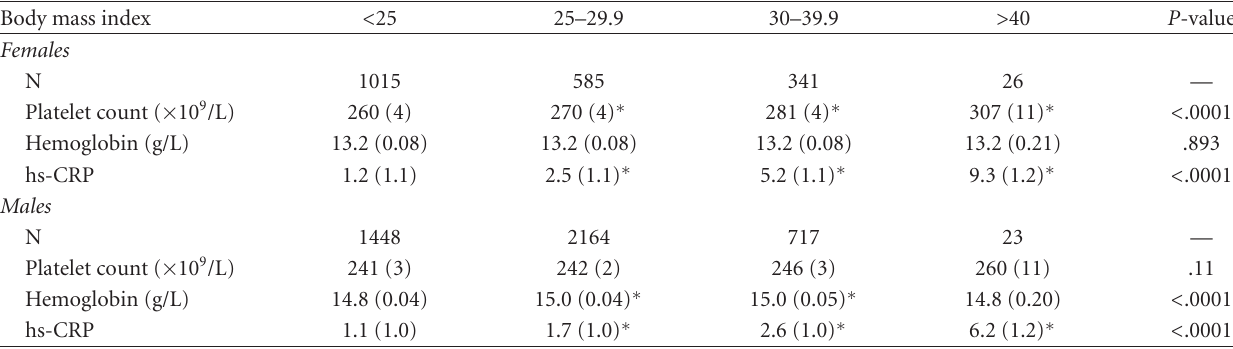
Table 2: Age, hypertension, and diabetes mellitus adjusted estimated marginal mean (standard error of the mean) of platelets count, hemoglobin concentration, and CRP stratified by BMI.